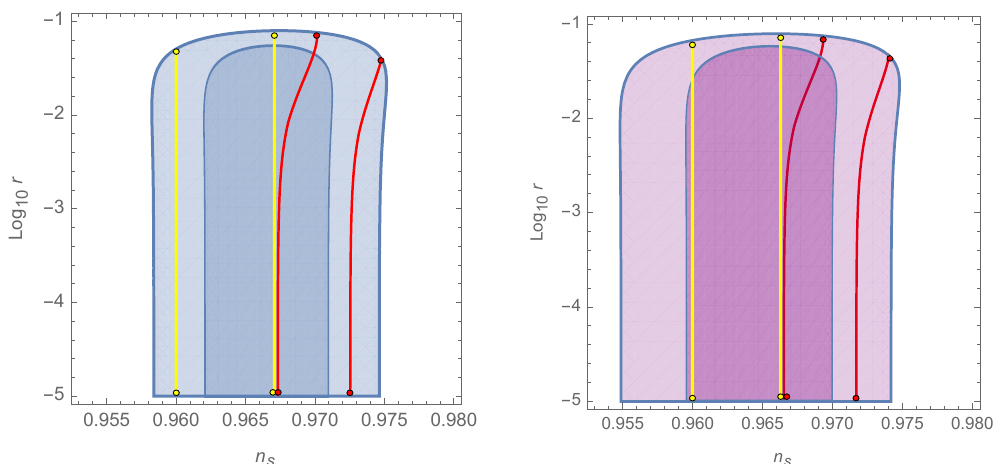
Figure 2 . Comparison of predictions of (cid:11) -attractors and of the D-brane in(cid:13)ationary model with 4 m V 1 within the 2 (cid:27) area of the Planck 2018 results for n s and r . On the left panel, the (cid:30) (cid:24) (cid:0) dark (light) blue area is the Planck 2018 1 (cid:27) (2 (cid:27) ) region, with an account taken of the CMB-related (cid:16) (cid:17) data. The right panel represents the Planck 2018 results based on the CMB related data only, without BAO. Two yellow lines on both panels are for the quadratic T-model of (cid:11) -attractors at N e = 50 and N e = 60. Two red lines are for the simplest D-brane in(cid:13)ation model V = 1